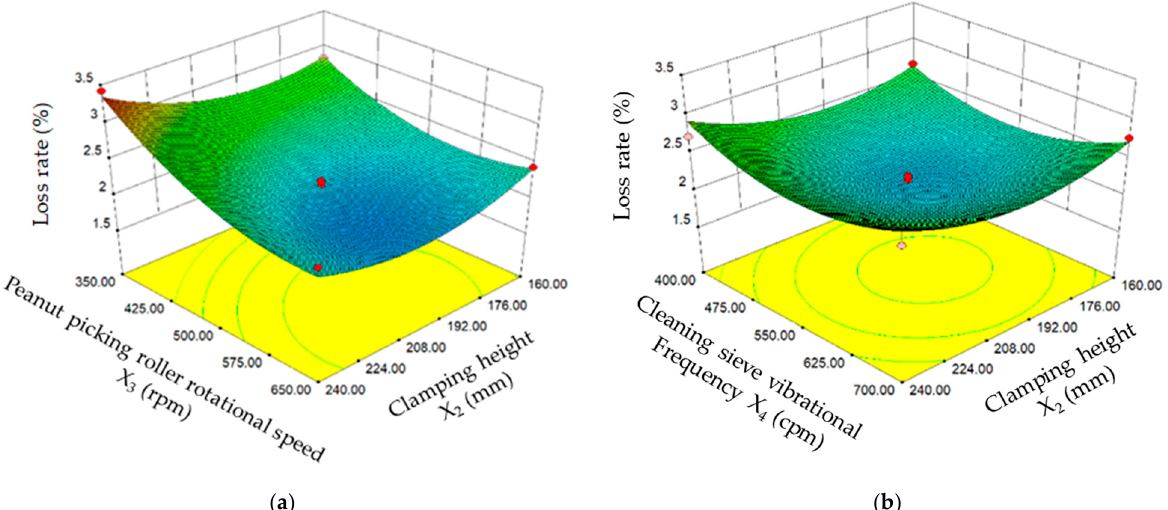
Figure 12. Effects of the interaction factors on the loss rate. ( a ) Interaction of X 2 with X 3 for X 1 = 1.0 m/s , X 4 = 600 cpm. ( b ) Interaction of X 2 with X 4 for X 1 = 1.0 m/s, X 3 = 500 cpm. X 4 = 600 cpm. ( b ) Interaction of X 2 with X 4 for X 1 = 1.0 m/s, X 3 = 500